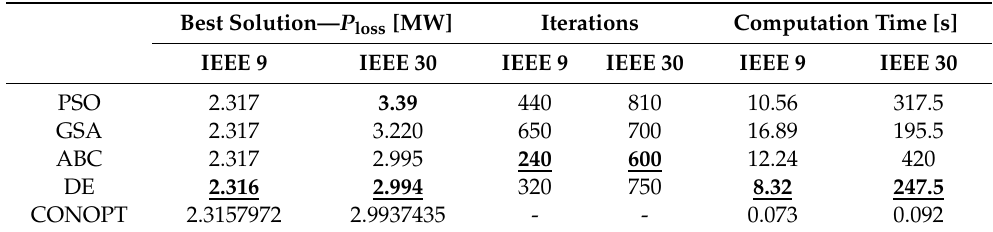
Figure 5. OF in 1st, 50th, and 300th iteration at PSO, GSA, ABC, and DE algorithms’ multiple runs, ( a ) IEEE 9 test bus system, ( b ) IEEE 30 test bus system. Table 1. Comparison of the algorithms regarding the best solution, the number of iterations needed to achieve the best solution, and computation